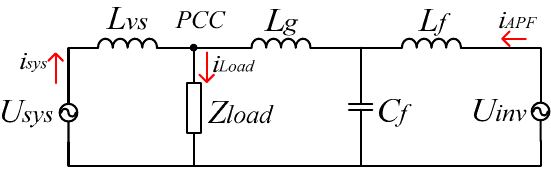
Figure 8. External circuit of shunt active power filter system.